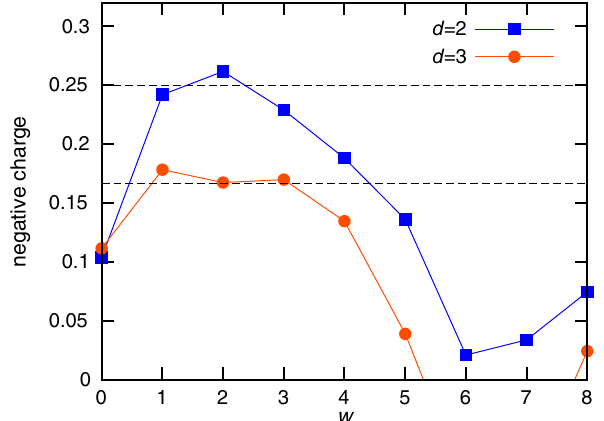
FIG. 15. Witten effect measurement, similar to Fig. 8, but for the case where d hedgehogs are bound to each boson. The amount of bound charge is given by 1 = ð 2 d Þ , as expected (indicated by dashed lines). Parameters K , β , and λ are chosen to put the bulk into the binding phase, while γ is chosen to minimize the amount of charge away from w ¼ 2 , though the value at w ¼ 2 is independent of this choice.